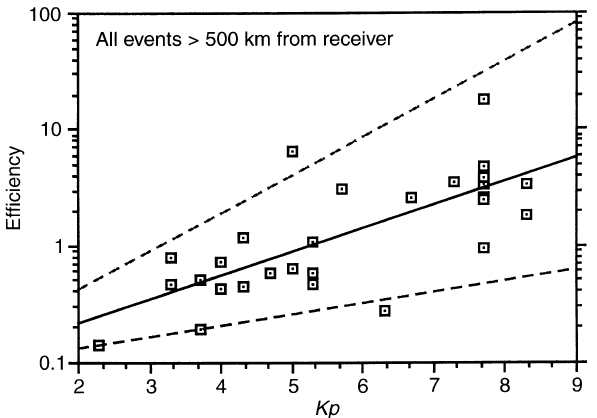
Fig. 6. A plot of the estimated e(cid:129)ciency of all ducts versus K p . The plot shows a logarithmic relationship between the two. The upper and lower boundaries are delineated and indicate a trend of increasing scatter with increasing K